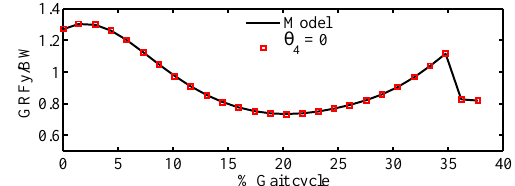
Figure 11. GRFy results for SS phase with all DOF and without the frontal plane rotation of the leg ( θ 4 = 0) with AFROS. The results from the model using FROS are similar. (Gait cycle starts at toe-off of the other leg, that is, at the beginning of SS.)